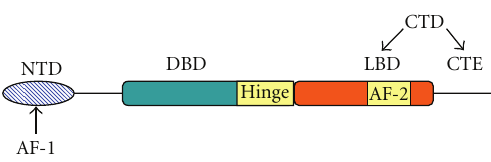
Figure 1: Schematic representation of the structure of human androgen receptor NTD: N-terminal domain, DBD: DNA-binding domain, LBD: ligand-binding domain, CTE: C-terminal extension, CTD: C-terminal domain, AF-1: activation function-1, AF-2: activation